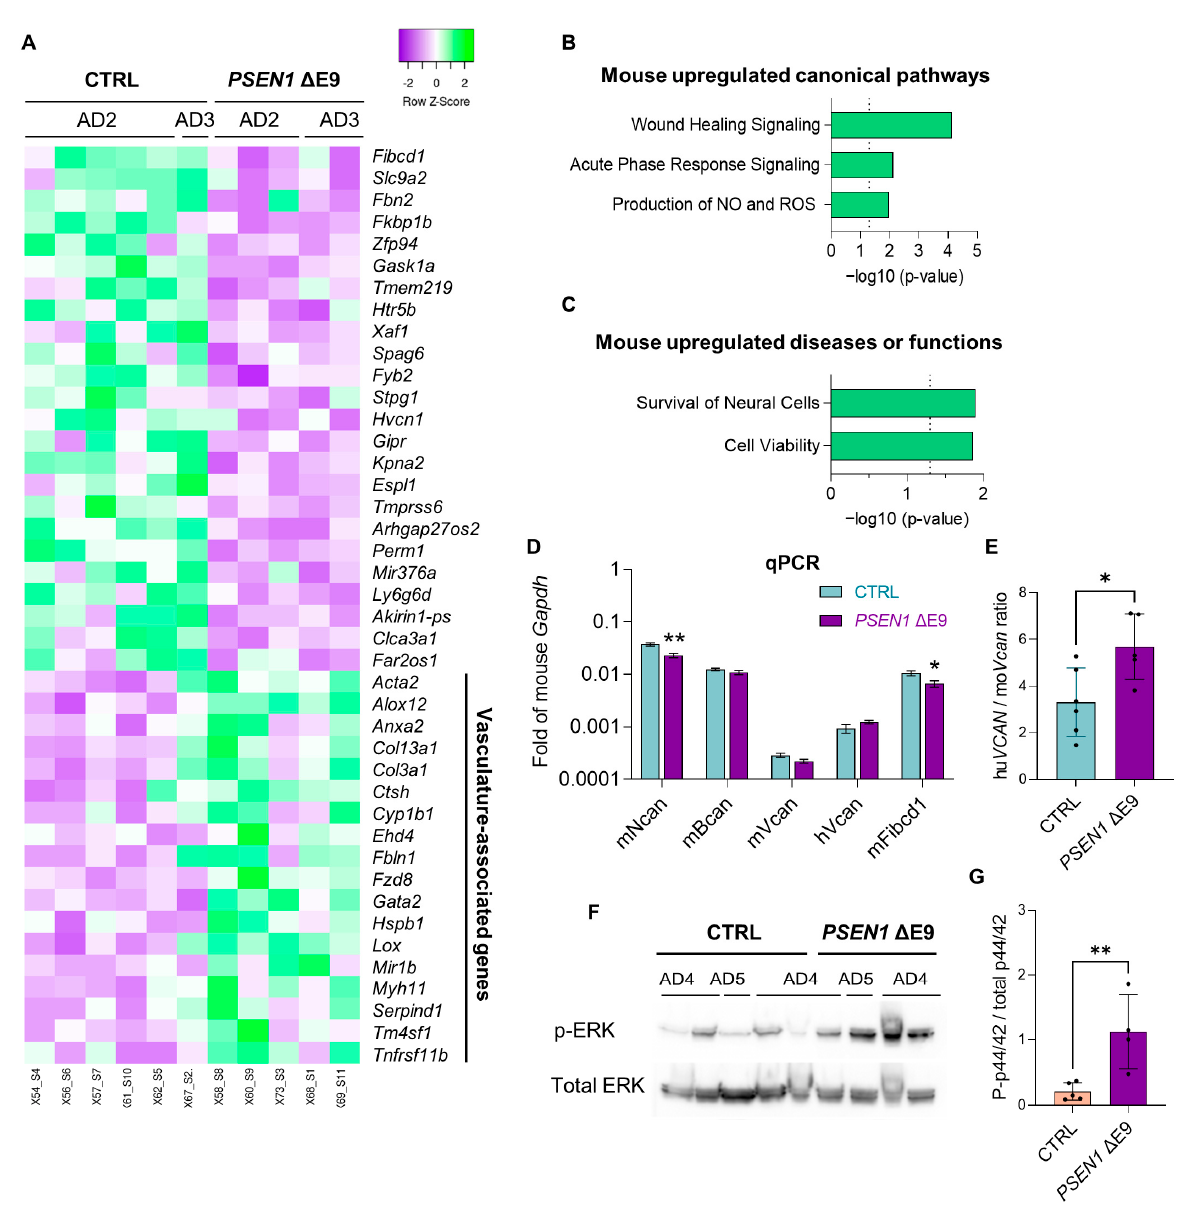
Figure 6. PSEN1 Δ E9 mutant human glial cells induce changes in neighboring mouse cells in hippocampi. ( A ) A heatmap showing the relative expression changes in differentially expressed mouse genes labeled by genotype (CTRL vs. PSEN1 Δ E9) and parental iPSC line of the transplanted cells (AD2 vs. AD3); purple indicates low and green high expression level normalized to row average. ( B , C ) Ingenuity pathway analysis of mouse PSEN1 Δ E9 vs. CTRL DEGs; significantly upregulated pathways indicate Z-score ≥ 1.99; threshold of significance –log10 ( p -value) = 1.3 ( p = 0.05; dotted line). ( D ) RT-qPCR data showing relative expression of CSPG-related genes, all shown as fold of expression of mouse housekeeping gene Gapdh. ( E ) A relative expression of the human VCAN gene shown as the fold of mouse Vcan gene expression. ( F , G ) Representative immunoblot labeled by genotype (CTRL vs. PSEN1 Δ E9) and parental iPSC line of the transplanted cells (AD2 vs. AD3) ( F ) and quantification analysis of phospho-ERK (Thr202/Tyr204) ( G ) in hippocampal lysates from female mice. Purple bars indicate PSEN1 Δ E9 glia-transplanted mice, blue bars indicate CTRL-transplanted males, and salmon CTRL-transplanted females. The data in the graphs are shown as mean ± SEM; n = 4–6 per group; * p < 0.05, ** p < 0.01 as compared to CTRL.